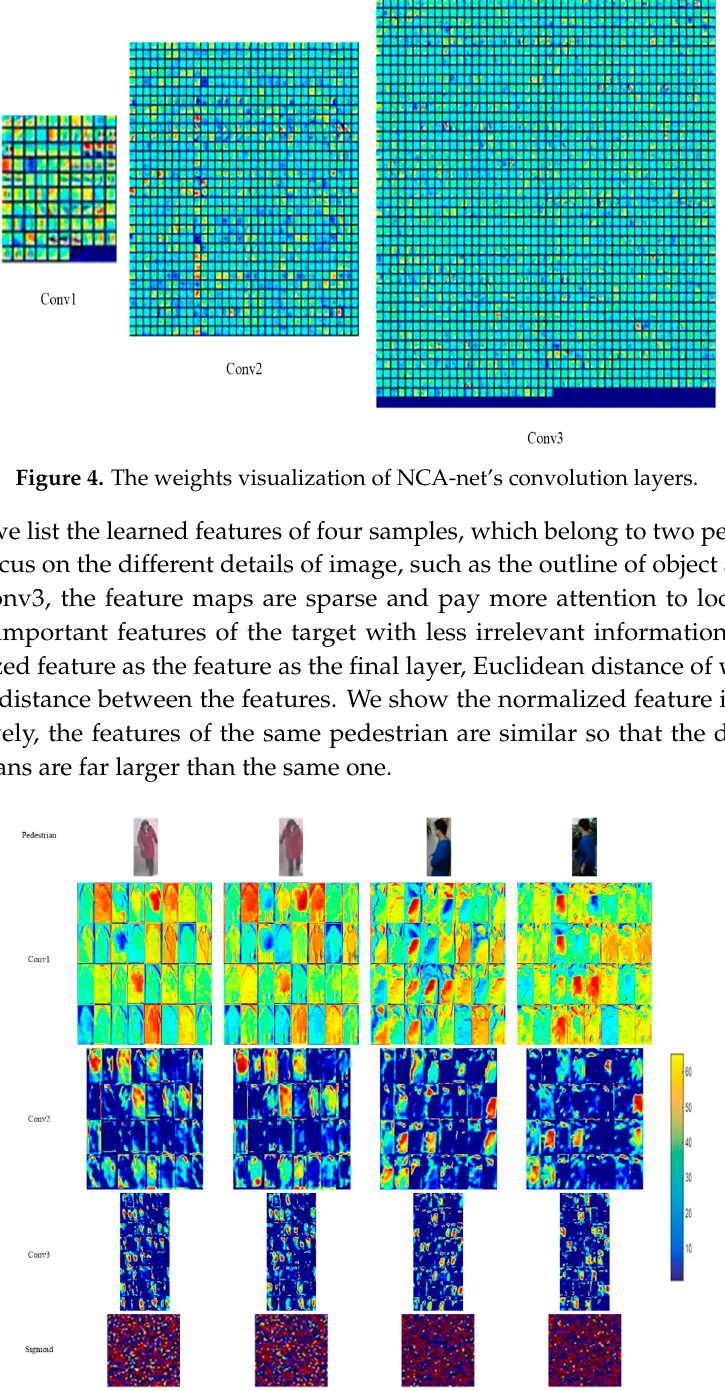
Figure 5. The visualization of features of two pedestrians extracted from NCA-net.